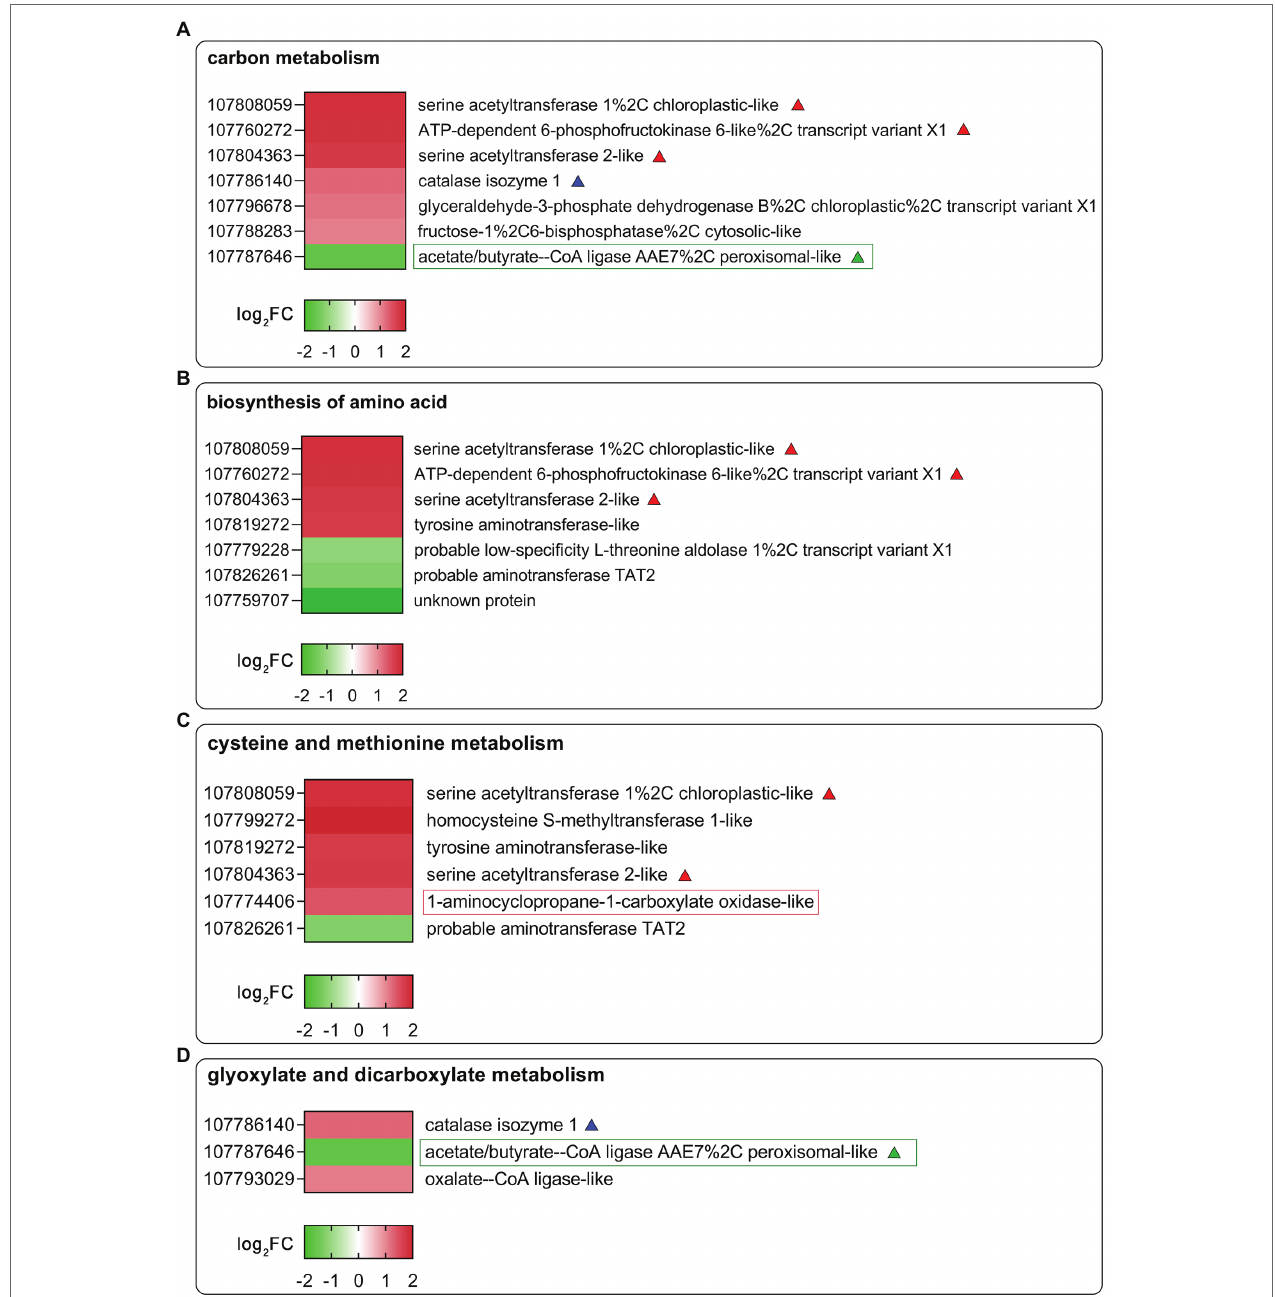
FIGURE 5 | Heat map diagrams of DEGs related to carbon metabolism (A) , biosynthesis of amino acids (B) , glyoxylate and dicarboxylate metabolism (C) , and cysteine and methionine metabolism (D) in response to SHAM treatment. DEGs of |log 2 FC ≥ 1| are shown in the image. log 2 FC, log 2 FoldChange. The red-, blue-, and green-colored triangles or rectangles represent DEGs that appear in different KEGG